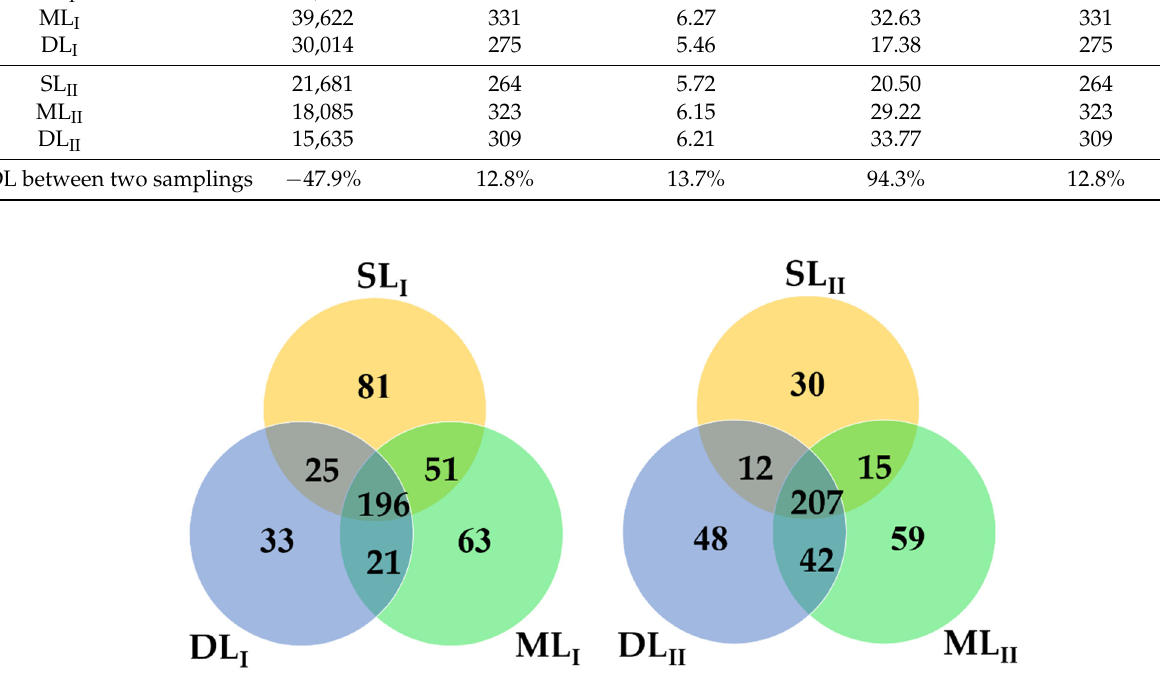
Figure 4. Venn diagram showing differences in the composition and structure of microbial OTUs under different soil heavy metal contamination levels.